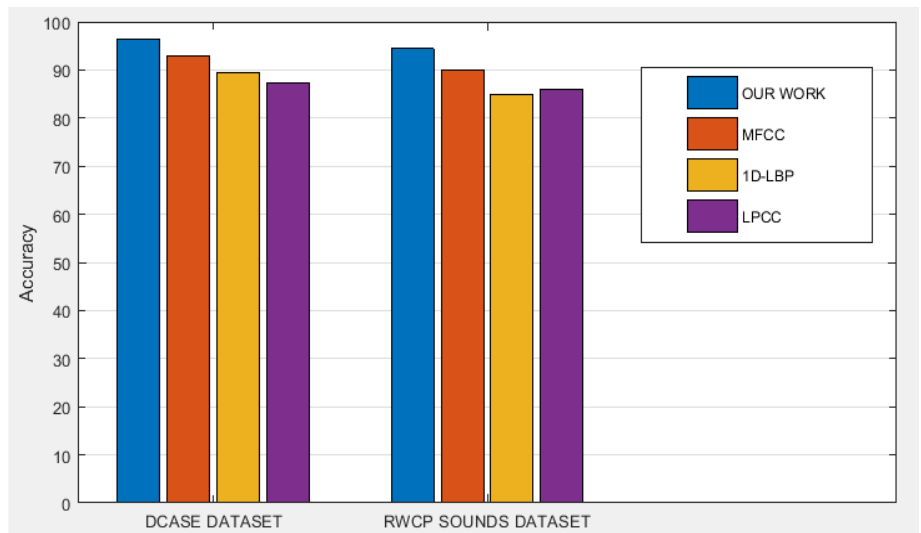
Figure 4: Acoustic scene classification evaluation over Figure 6. Classification performance of the proposed ID-LTP and several other features over DCASE and DCASE and RWCP dataset RWCP